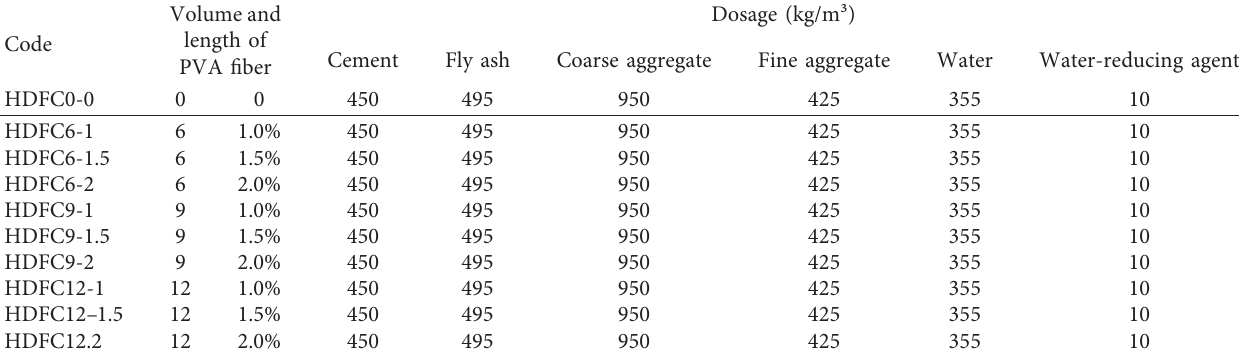
Table 1: Concrete mix proportion design of HDFC.